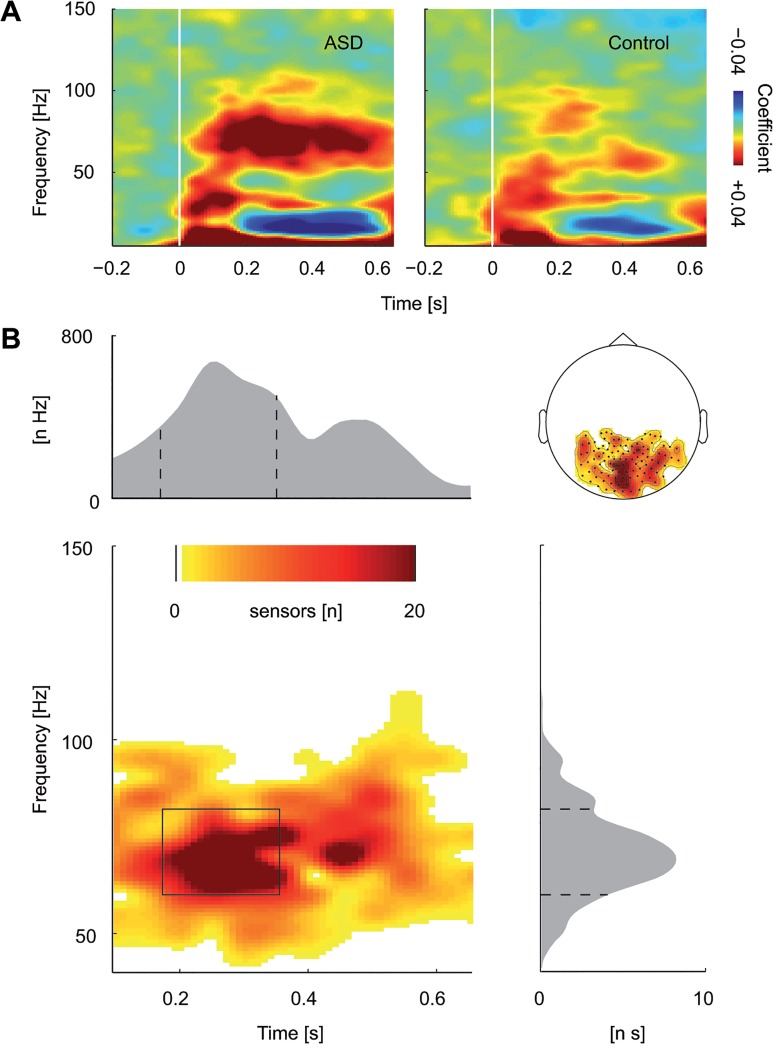
Linear coefficients estimated with polynomial regression.(A) Time-frequency representation of the linear coefficients, averaged across posterior sensors (see schematic head in Fig 2) and within groups (left: ASD, right: Control). (B) Time-frequency representation of the statistical difference of linear coefficients compared between groups (ASD—Control). Colors represent numbers of sensors belonging to the significant cluster. Y-axes of the gray-shaded curves represent the integrated number of sensors (number of sensors [n] multiplied with the respective domain, time [s] or frequency [Hz]).